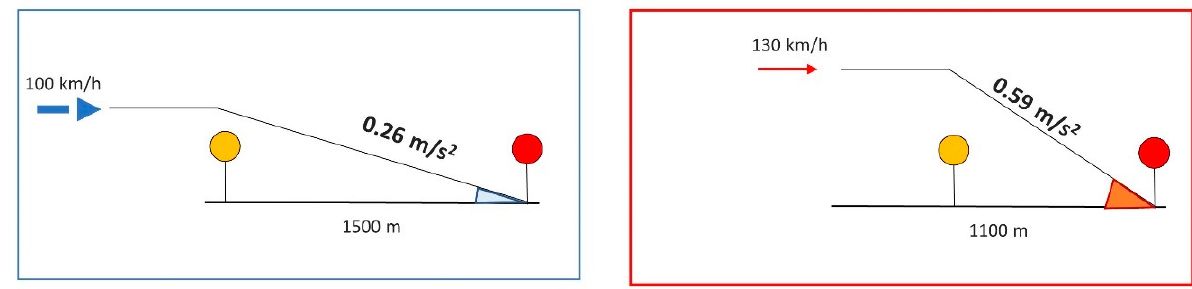
Figure 3. There is variation in the necessary rate of deceleration. In the left approach, a continuous deceleration rate of 0.26 m/s 2 is sufficient to stop in front of the red signal, while the approach on the right requires a deceleration rate of at least 0.59 m/s 2 .